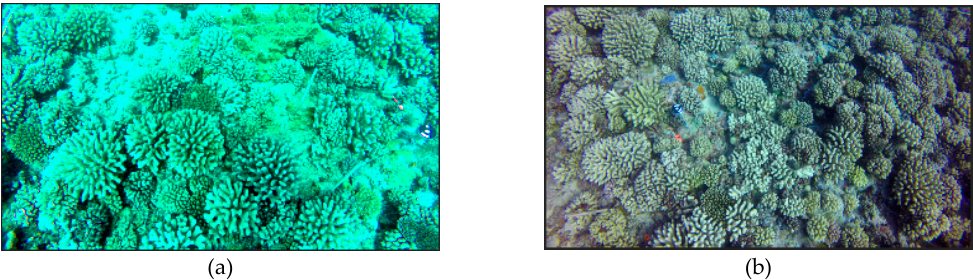
Figure 10. Frames extracted from video taken with a GoPro Hero 4 Black camera recorded without ( a ) and with ( b ) the red filter.